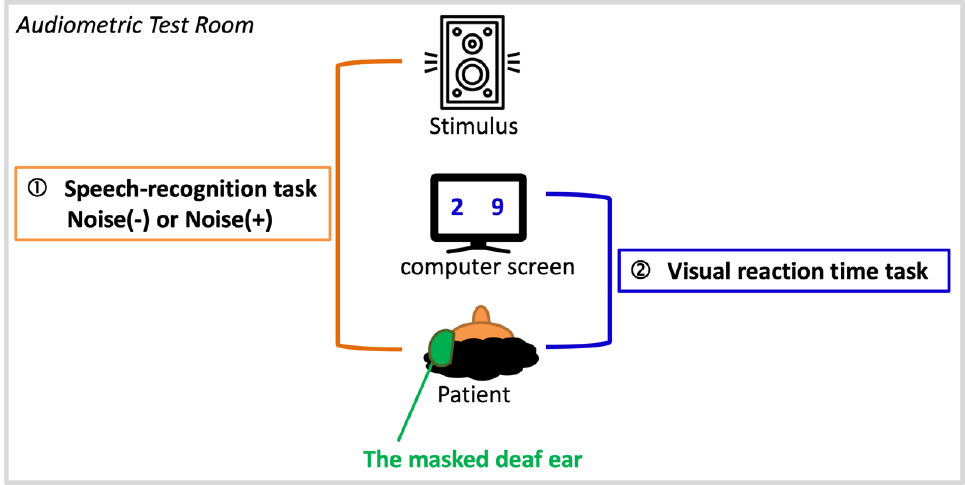
Figure 1. Schematic illustration of a dual-task paradigm composed of a primary task-speech recognition task in quiet (noise−) or noise (noise+) and a secondary task-visual reaction time task. The dual-task paradigm started with a primary task, which was a speech recognition task. The speech stimulus was presented through a loudspeaker 1 meter in front of the patients. The stimuli were phonetically balanced words spoken by male narrators in Mandarin [33]. The sound pressure levels of the stimuli were controlled by a GSI 61 clinical audiometer (Grason Stadler Inc., Eden Prairie, MN, USA) and were set to 40 dB above the speech recognition threshold of the unaffected ear to ensure adequate sound stimulation.